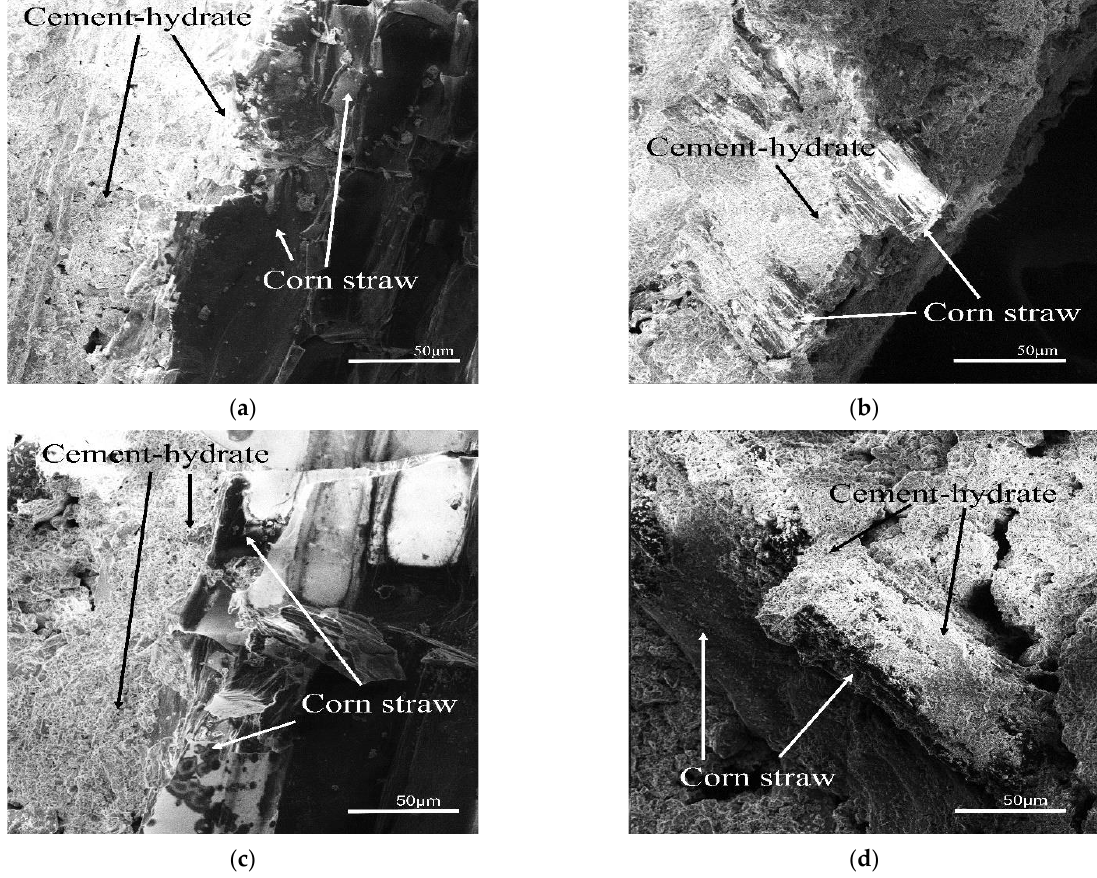
Figure 13. Microstructure of CSCC; ( a ) CSCC-5, ( b ) CSCC-6, ( c ) CSCC-7 and ( d ) CSCC-8.